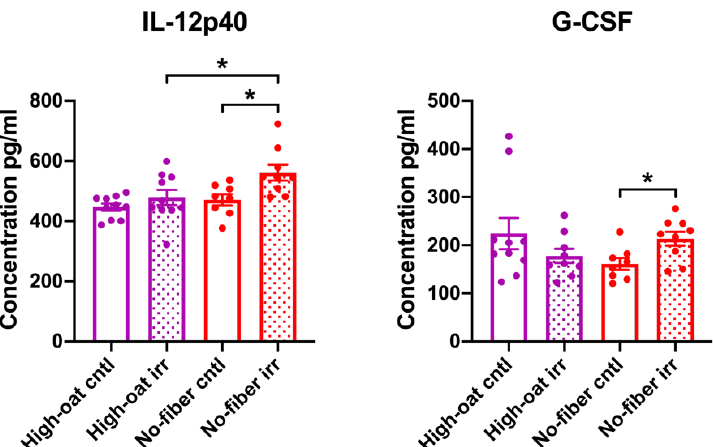
Figure 4. Serum cytokine and chemokine levels in mice at 6 weeks post-irradiation. A two-tailed Student’s t -test was used to compare the cytokine levels in the High-oat irr vs. High-oat cntl, No-fiber irr vs. No-fiber cntl, High-oat irr vs. No-fiber irr, and High-oat cntl vs. No-fiber cntl groups. Data shown are average concentrations and the error bars represent SEM. * p ≤ 0.05.